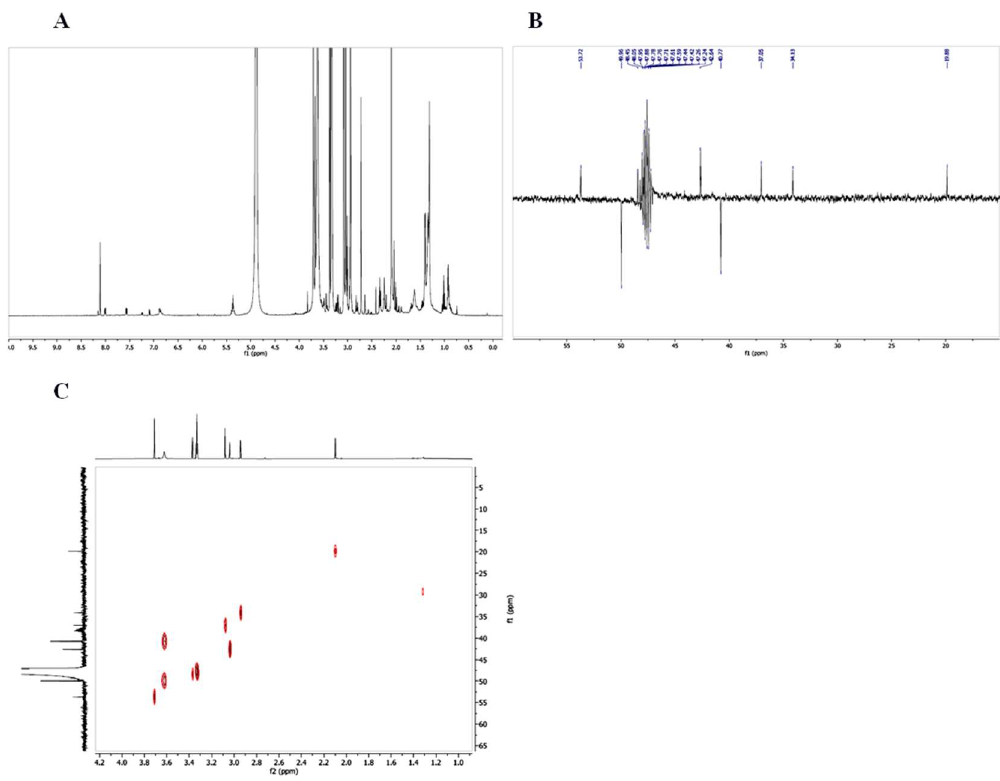
Figure 7. The NMR spectra of the biosurfactant compound. 1H in CD3OD (10 to 0 ppm) ( A ); 13C DEPT-135 in CD3OD (60 to 15 ppm) ( B ); 1H-13C HSQC one bond in CD3OD ( C ).